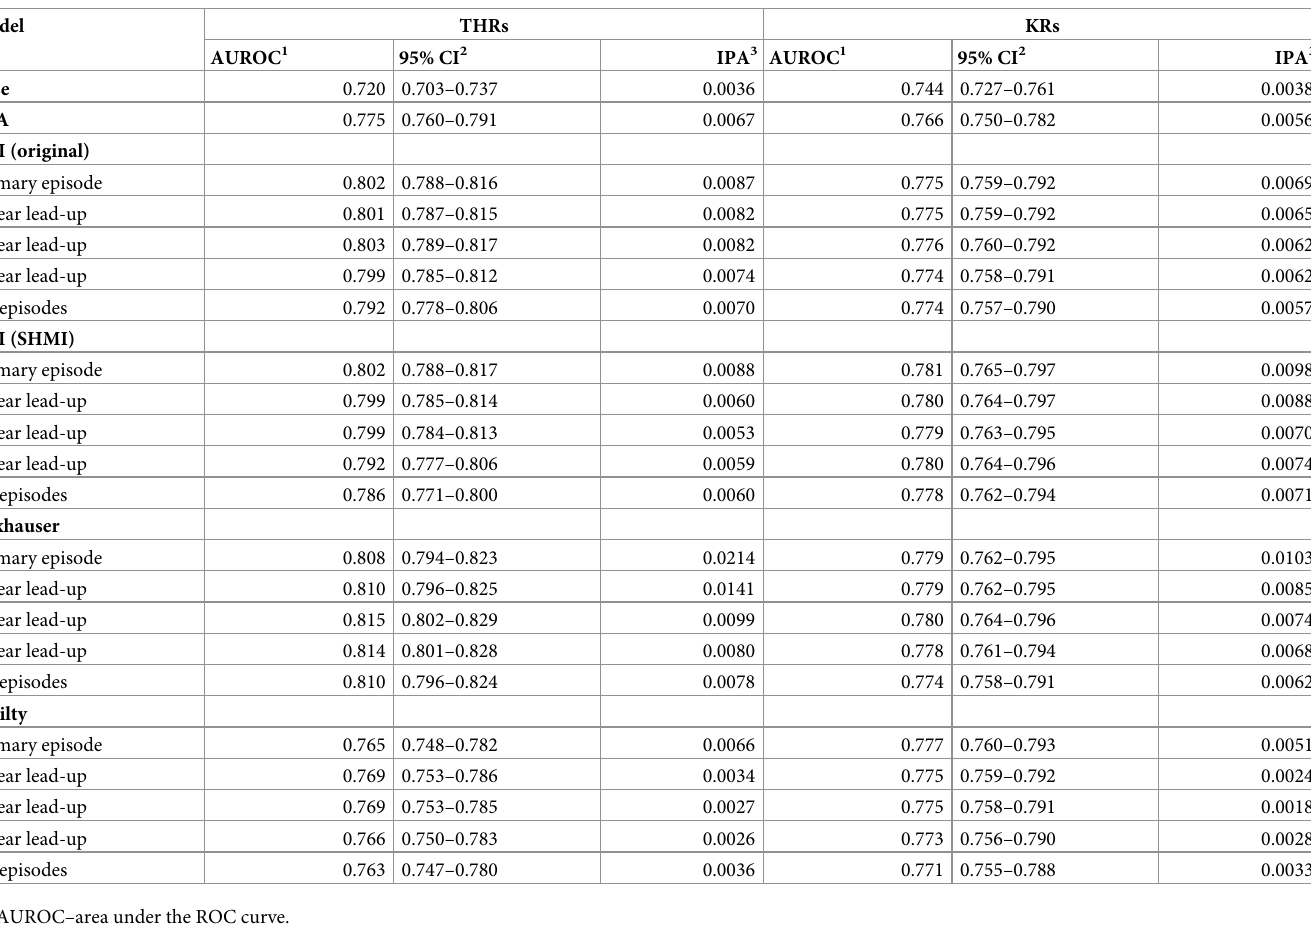
Table 3. The area under the ROC curve and IPA for ASA grade and all comorbidity scores for models of 90-day mortality after THR and KR, adjusted for age and